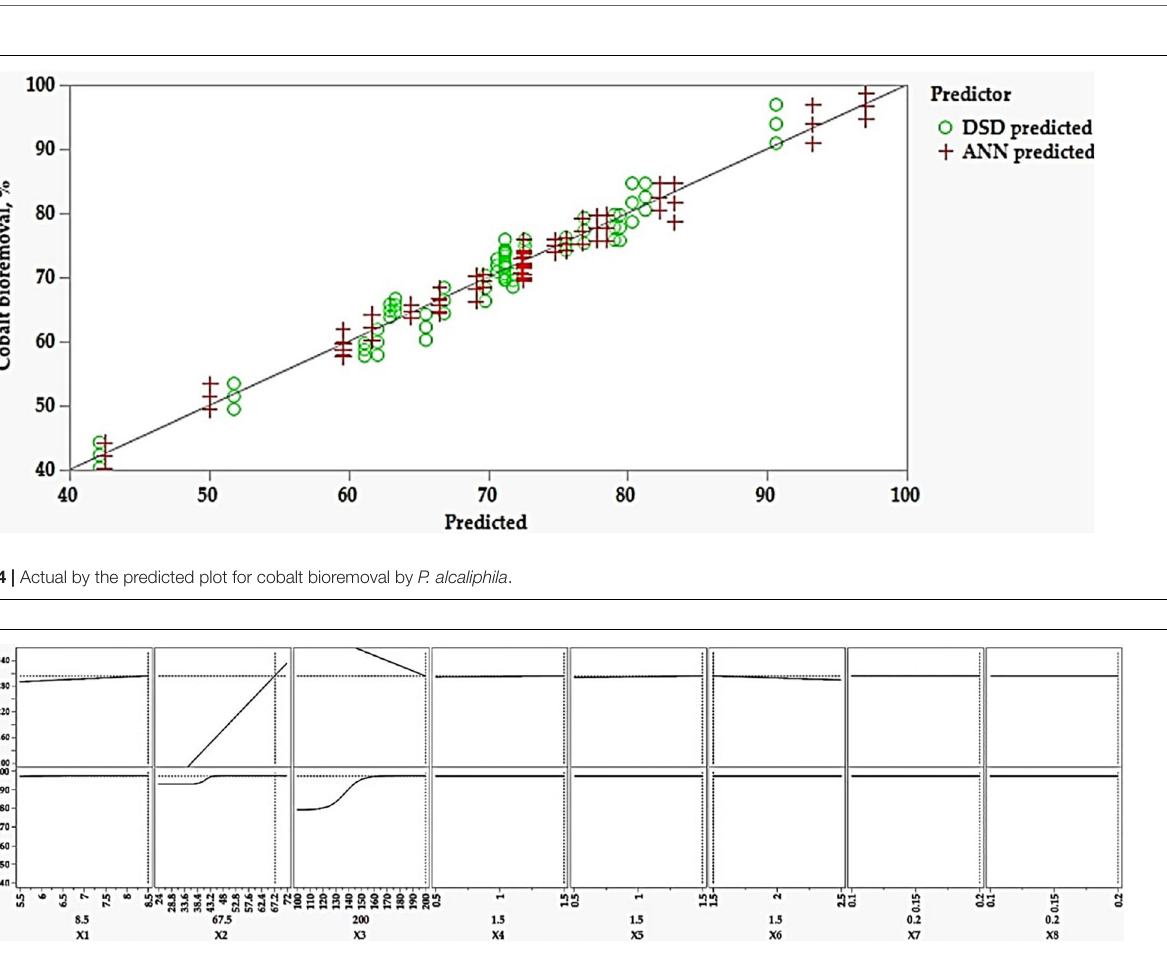
FIGURE 5 | The estimated values of the tested parameters based on DSD and artificial neural network (ANN) models and the corresponding predicted cobalt bioremoval by P. alcaliphila . X1, pH; X2, incubation time (h); X3, initial CoSO 4 .7H 2 O (ppm); X4, glucose (%); X5, glycerol (%); X6, peptone (%); X7, K 2 HPO 4 (%); and X8, MgSO 4 .7H 2 O